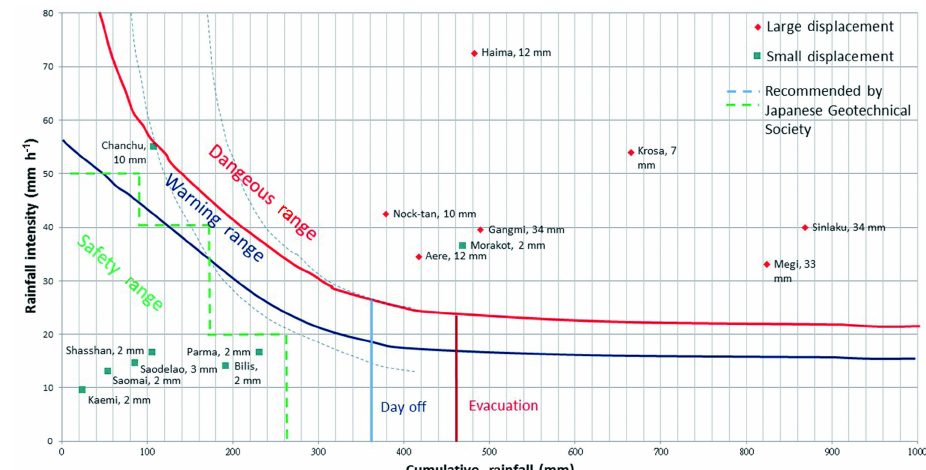
Figure 22. Threshold value curves (red and dark blue) correlated with slope displacement. The slope displacement (diamond and square marks) induced by typhoons over 2003 to 2010 can be derived from the relationship between average rainfall intensity and cumulative rainfall. Displacement less than 2 mm and over 10mm is accordingly defined as threshold values to distinguish three ranges of safe, warning, and dangerous. Dashed curves recommended by the Japanese Geotechnical Society (2006) are also plotted for comparison.